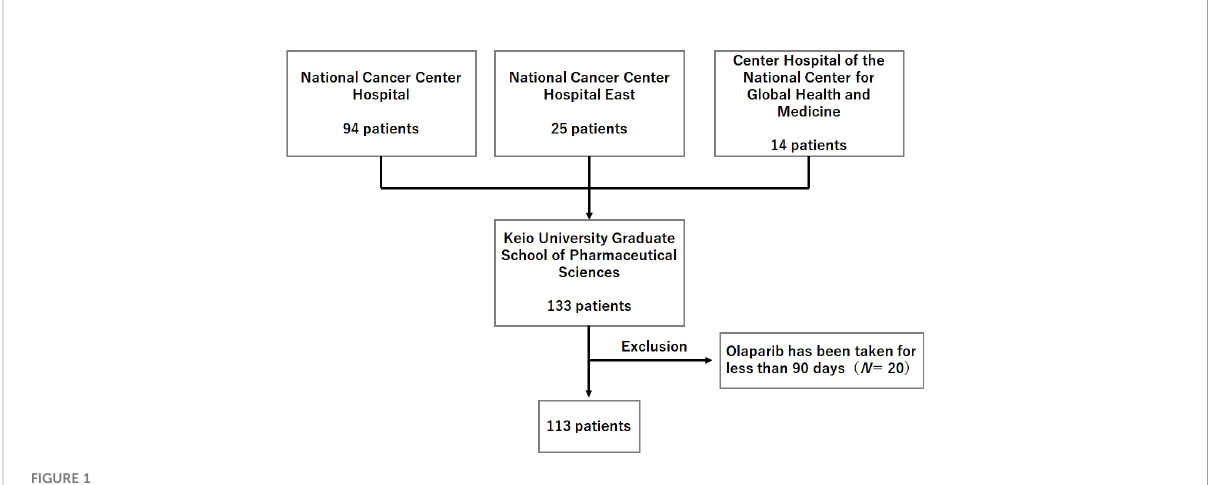
FIGURE 1 Flowchart illustrating the patient enrollment